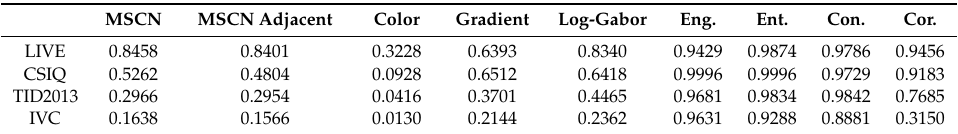
Table 2. Spearman Rank-Order Correlation Coe ffi cient (SROCC) values of each feature used in BM-IQE on IQA databases.